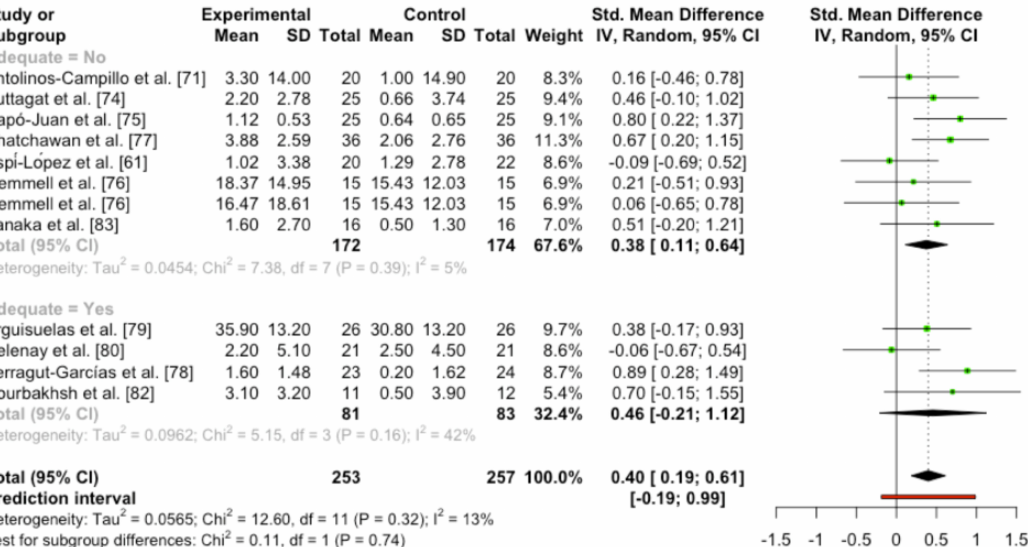
Figure 4. Risk of Bias Subgroup Analysis of soft tissue techniques trials. Positive values = In favor of intervention/Negative values = In favor of sham intervention. Standard Deviation (SD); Standard (std); Inverse Variance (IV); Confidence Interval (CI). No statistical difference was found between types of sham control groups (Q = 1.19;